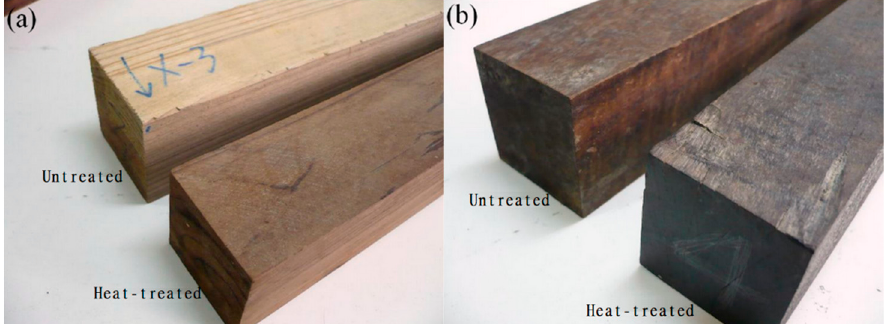
Figure 5. Appearances of untreated and heat-treated Japanese cedar ( Cryptomeria japonica ) ( a ) and Formosa acacia ( Acacia confusa ) ( b ) wood after the 50-day decay resistance test.